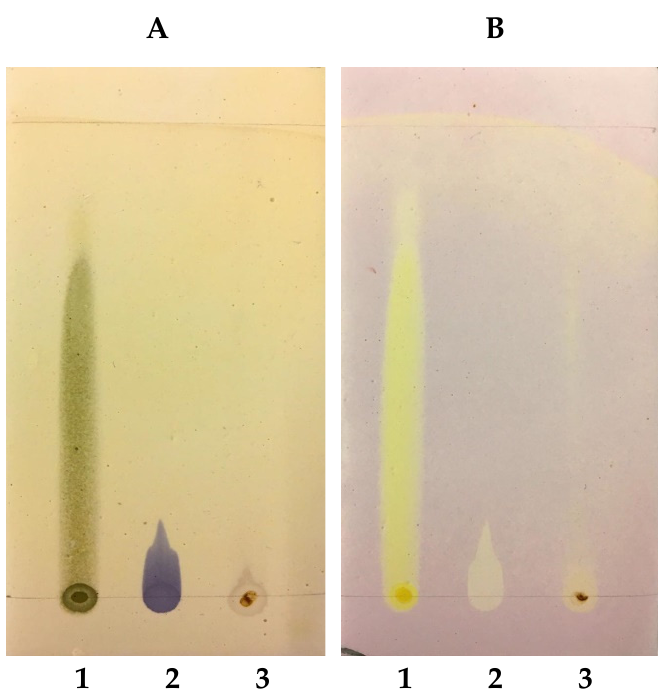
Figure 5. Gypsum-starch chromatoplates (1:1) from the AECHR stained with: A) FeCl 3 (detection 387 Figure 3. Gypsum-starch chromatoplates (1:1) from the AECHR stained with: ( A ) FeCl 3 (detection of phenols) and B) DPPH (detection of antioxidants). Quercetin (1); gallic acid (2); AECHR (3). 388 of phenols) and ( B ) DPPH (detection of antioxidants). Quercetin (1); gallic acid (2); AECHR (3). Chloroform/ethanol (9:1) elution. Chloroform/ethanol (9:1)